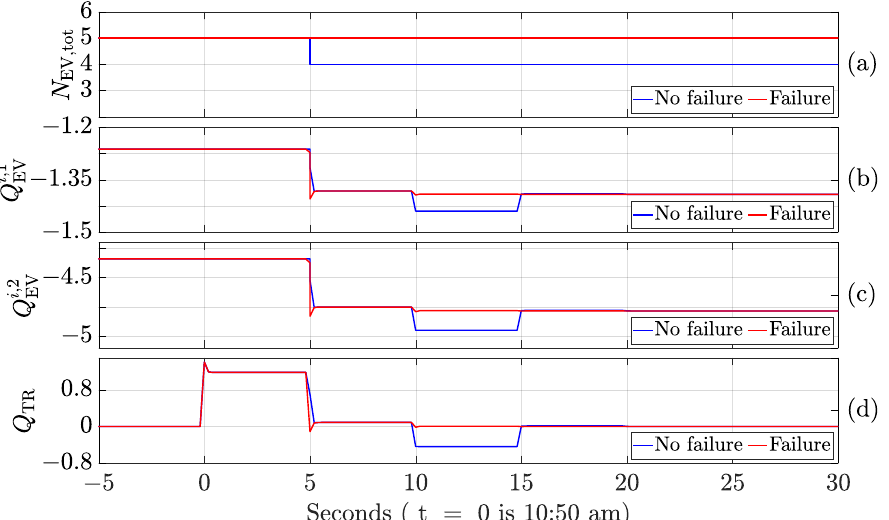
Figure 17. System response without and with communication failure case 1, (a) number of